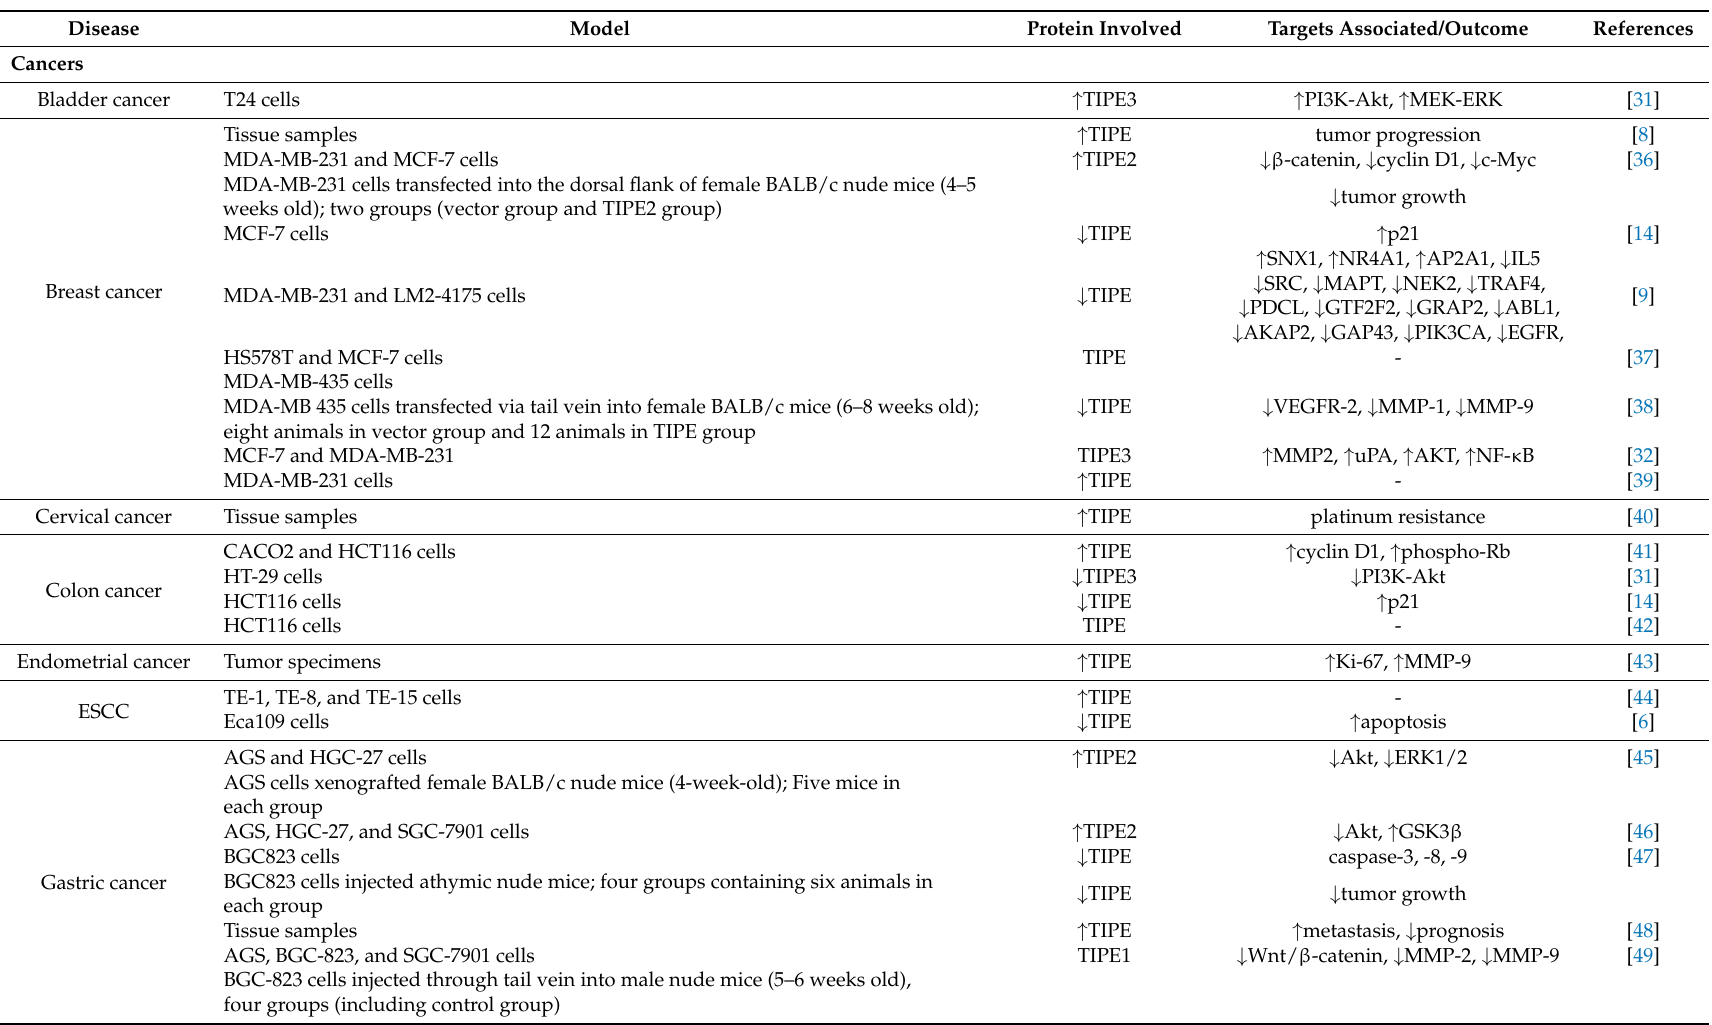
Table 1. Different chronic diseases and signaling pathways with known associations with the TIPE family of